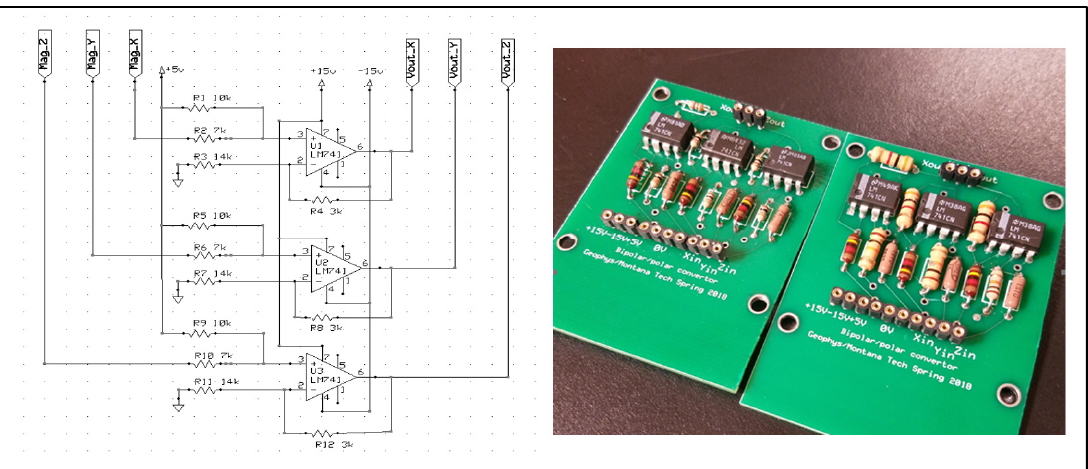
Figure 2. The bipolar to polar converter. Left panel shows the circuit schematic for the bipolar to polar converter, with associated summing amplifiers (LM741), resistor values, and power supplies. Right panel shows the same summing amplifier design with components soldered into a PCB.